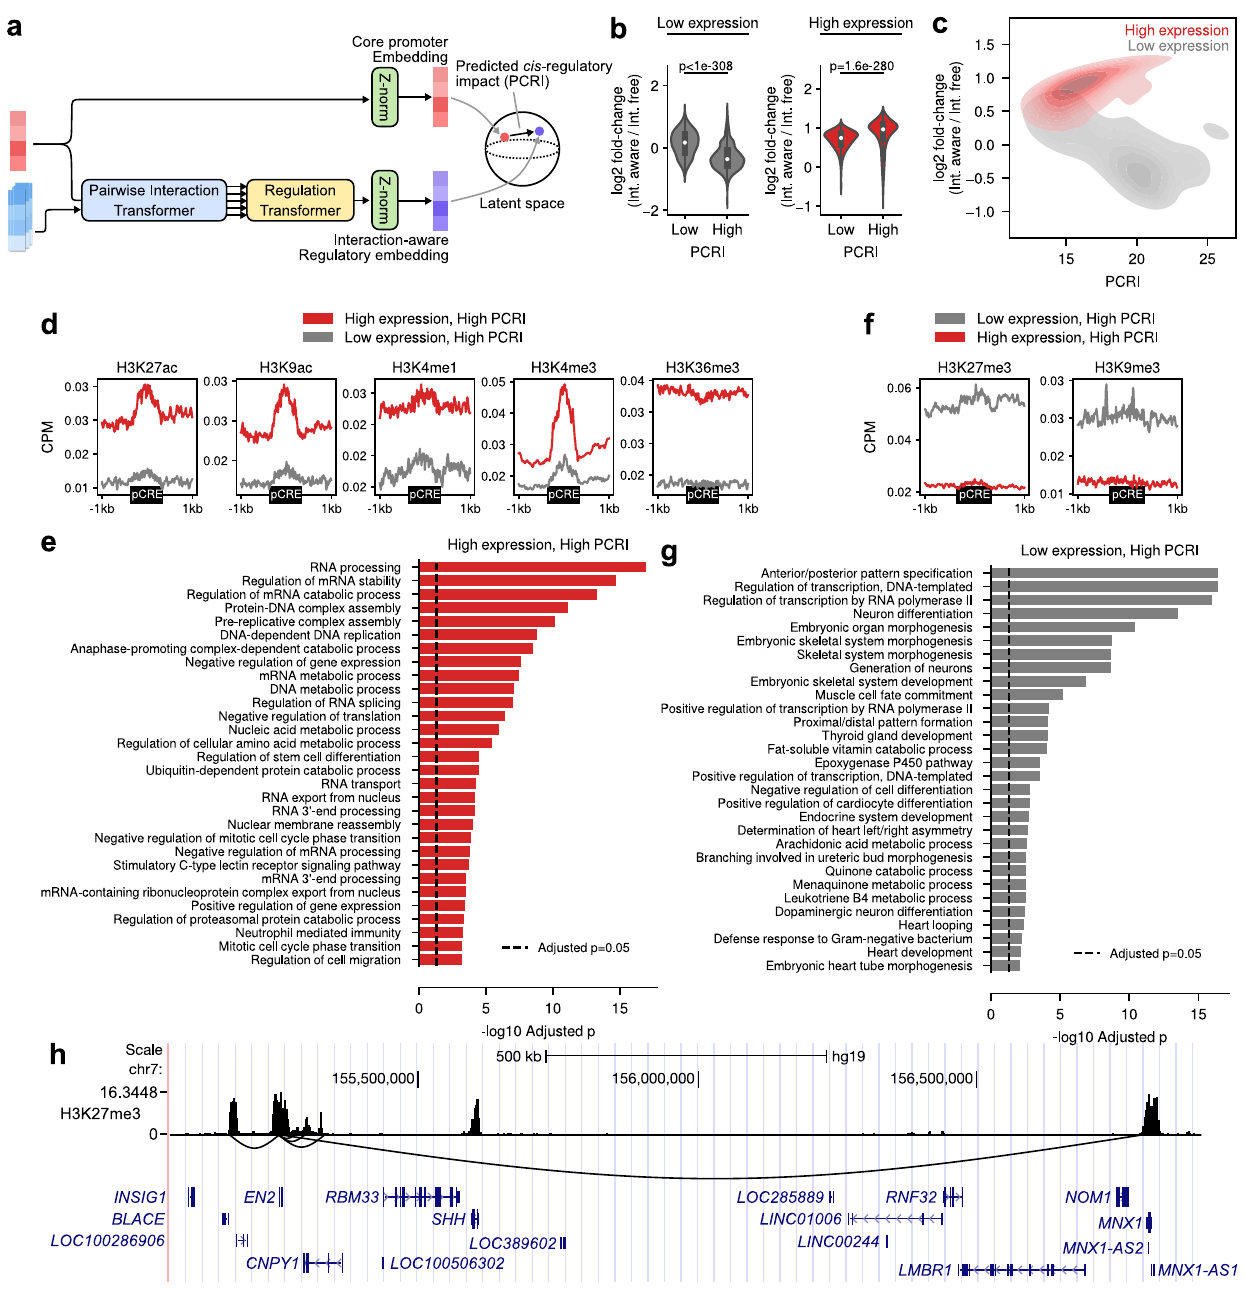
Fig. 5 | Analysis of predicted cis -regulatory impact (PCRI). a Schematic diagram illustrating the computation of the PCRI. b , c Relationship between PCRI and the log2 fold-change of predicted gene expression between the interaction-aware and interaction-free Chromoformer-reg in H1 cells (Epigenome identi fi er E003). Low andhighPCRIgroupswere splitbythemedianPCRIvalue.In b , p -valuesfromtwo- sided Wilcoxon rank-sum tests between genes with below-median PCRI ( n =4739 for both low and high expression groups) and above-median PCRI ( n =4738 and 4739 for low and high expression groups, respectively) are shown. In the boxes within the violinplot, the white point denotes the median and the upper and lower boxlimits denote upper and lowerquartiles. d Average HMsignals nearthe pCREs interacting with top 1000 genes with the highest PCRI among highly and lowly expressed genes. e Functional enrichment analysis of the top 1000 genes with the